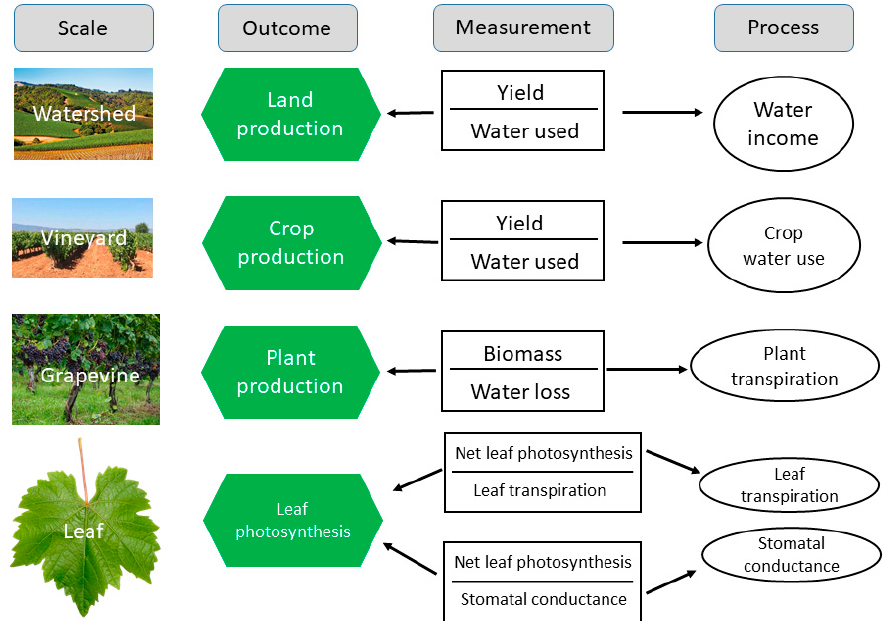
Figure 2. Measurement of the grapevine water-use efficiency at different scales, from the leaf to the watershed level (Adapted with permission from ref. [17]. Copyright 2015 INRA and Springer-Verlag France).